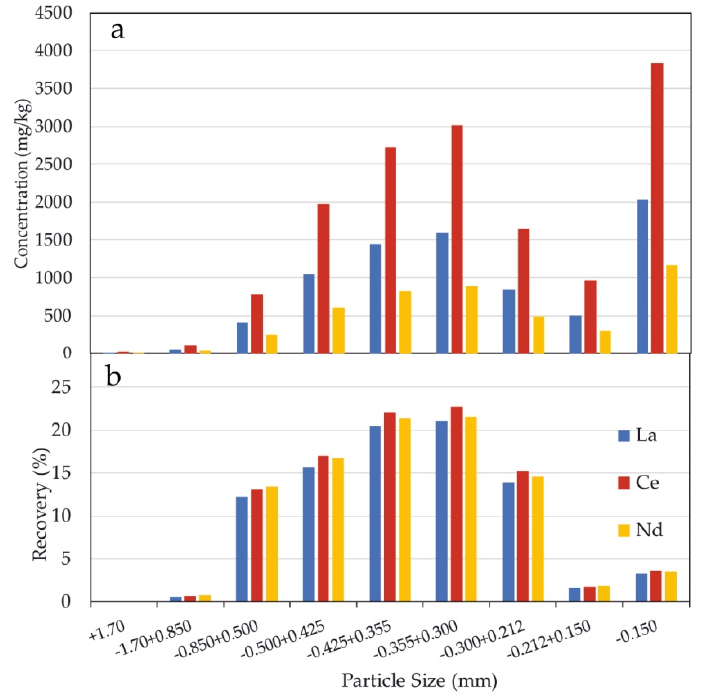
Figure 5. ( a ) Particle size analysis and light rare earth element (LREE) distribution (mg / kg) in sample A-mixed and ( b ) metal recovery in each particle size fraction, based on mass balance calculations (see text). Table 4. Particle size analysis and REE distribution in each particle size fraction.